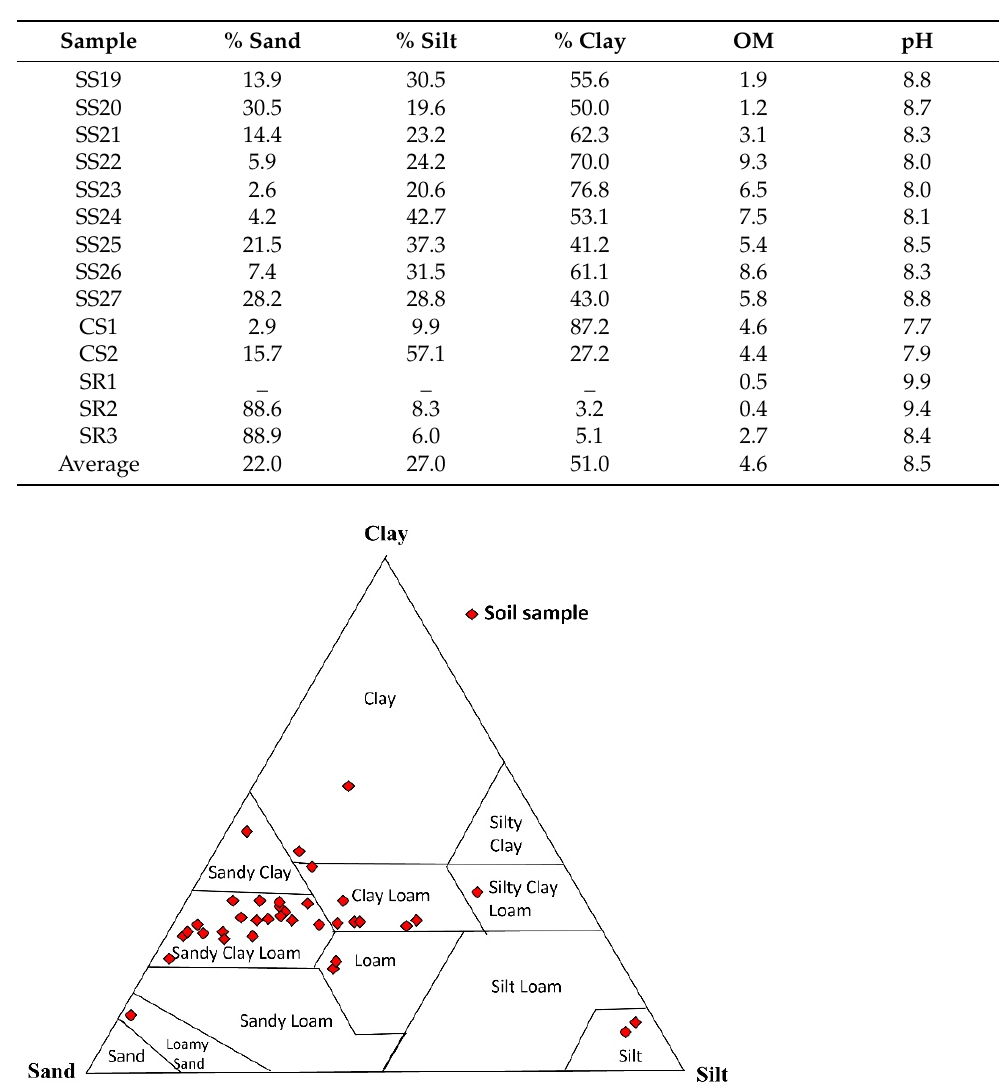
Figure 2. Classification of the studied surface soil samples according to their grain size. (After diagram; USDA, 2006 [36]).